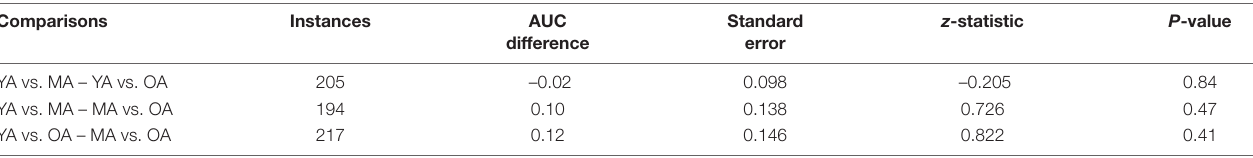
TABLE 3 | Comparisons of independent ROC